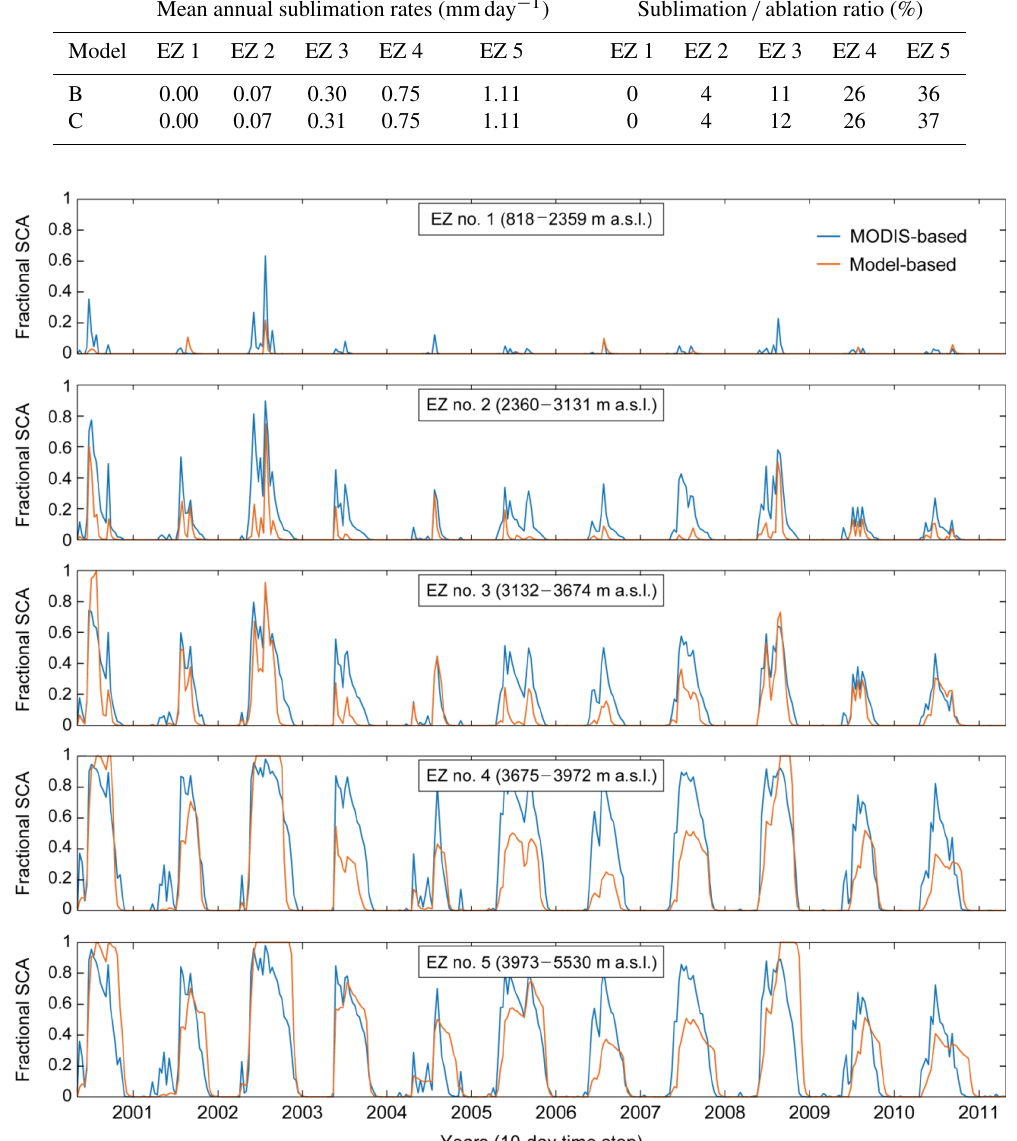
Figure 6. Comparison of simulated (i.e., Model C, accounting for sublimation) and observed (i.e., MODIS-based) fractional snow-covered areas (validation period). The graduations on the x axis indicate 1 January of each